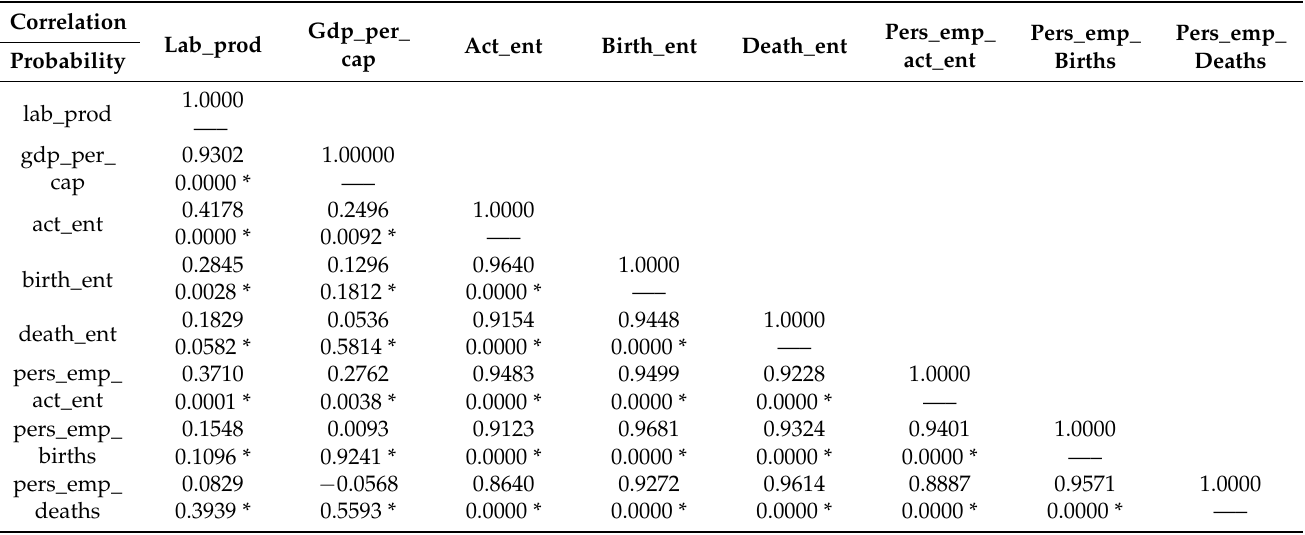
Table 5. Results of the correlation